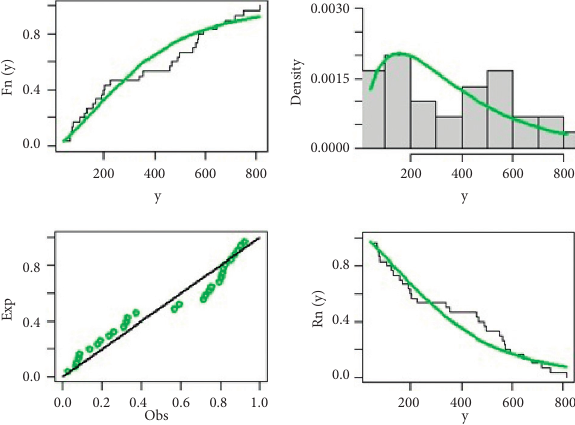
Figure 11: Plots of density, CDF, and survival of the GED for data set Table 8: SSR estimate of the breaking strength of jute fiber data.